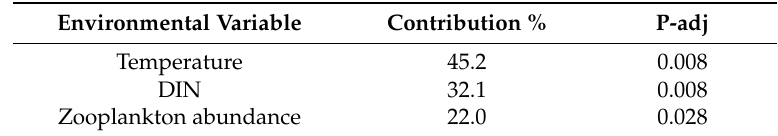
Table 2 . Explanatory variables for the abundance of potentially toxic cyanobacterial species. Table 2. Explanatory variables for the abundance of potentially toxic cyanobacterial